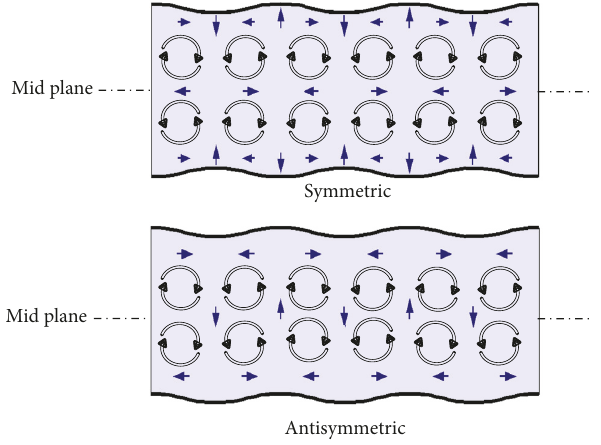
Figure 2: Displacement of Lamb wave